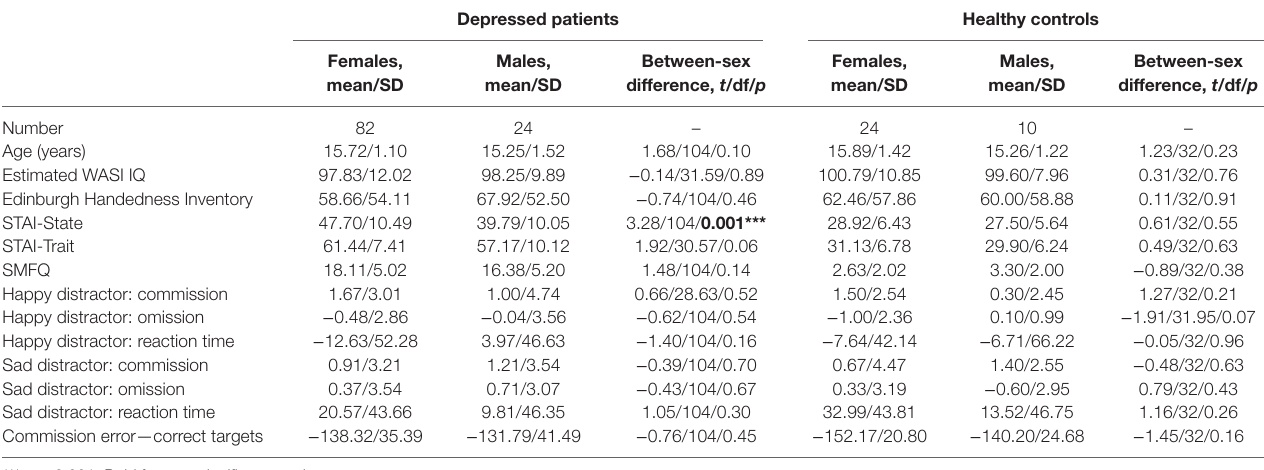
TaBle 1 | Between-sex differences in demographic and baseline